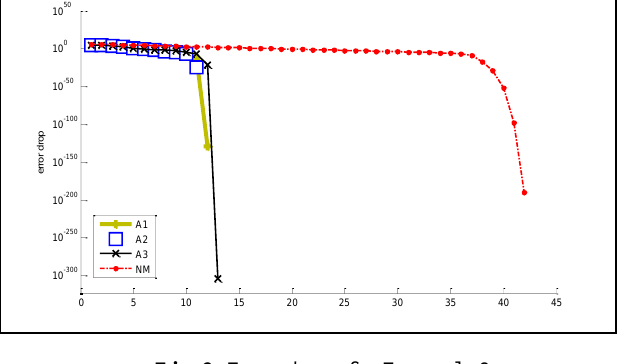
Fig. 13. COC in Example 6